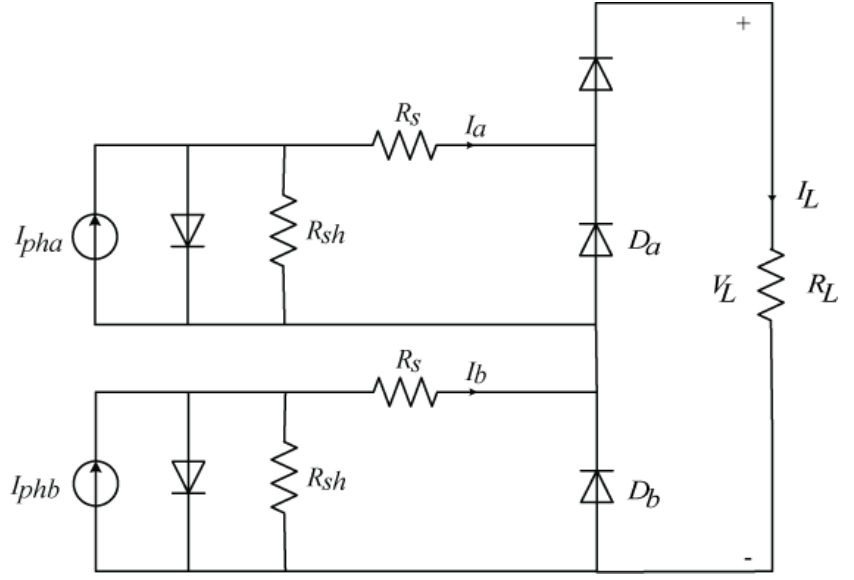
Figure 3. Equivalent circuit diagram of two PV modules connected in series.